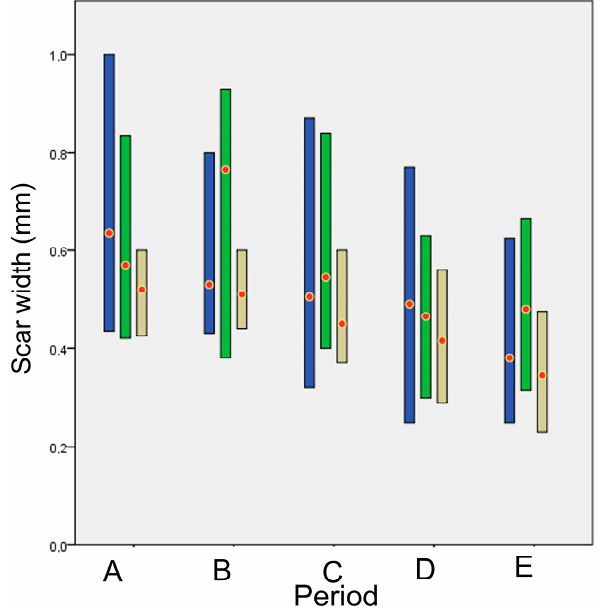
Figure 5. Median scar width (in mm) for each technique (blue: staples, green: glue, gray: intrader- mal) at each time point.[period A: 1-8 po.d.; period Β : 9-21 po.d.; period C: 22–63 po.d.; pe-riod D: 64–180 po.d.; period E: 181–365 po. d].